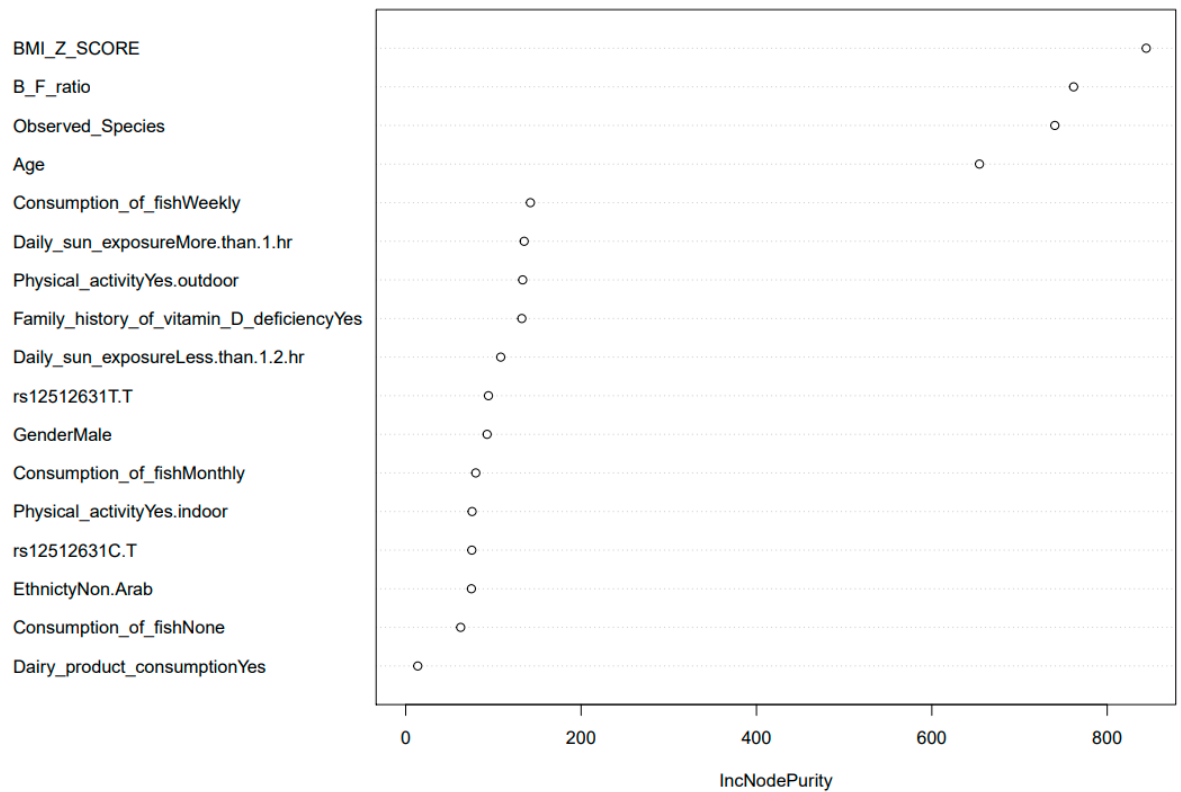
Figure 6. Random forest analysis used to determine the variables that had the largest contribution in determining the vitamin D levels. Inc Node Purity was used as a measure of “variable importance”.